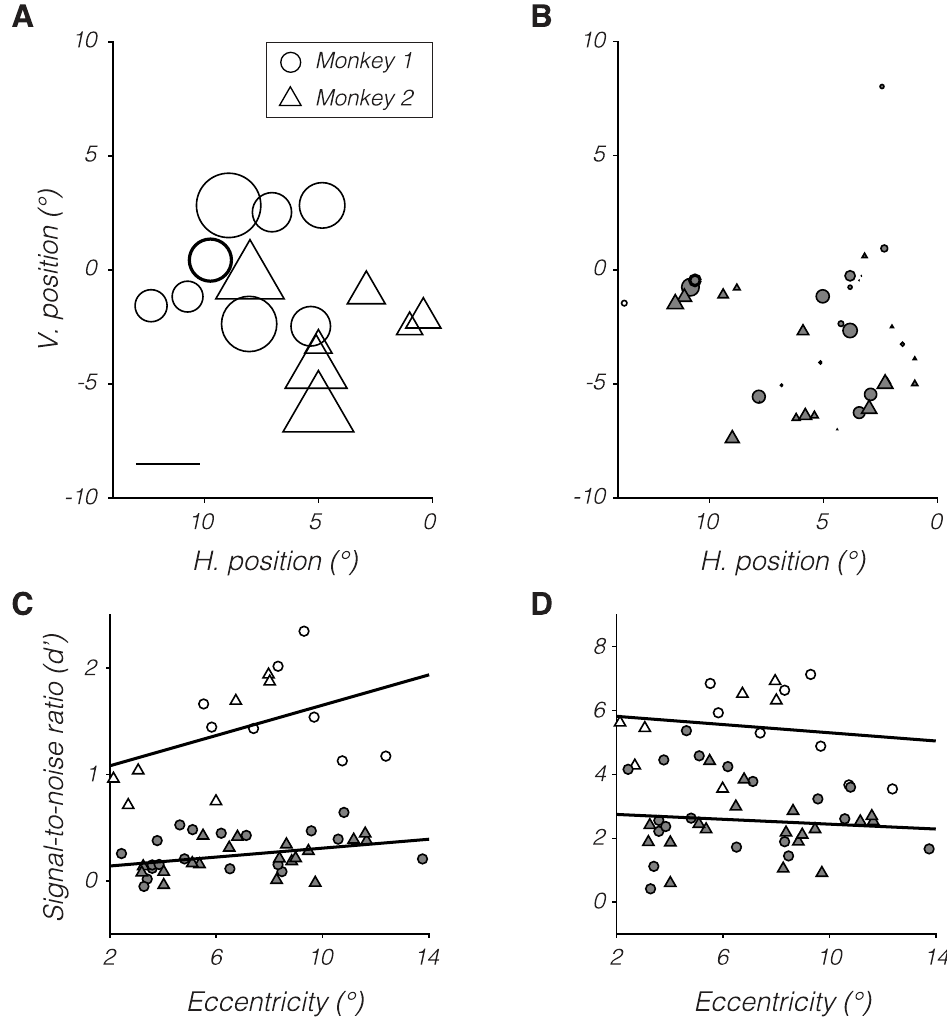
Fig 3. Dependence of d 0 on RF location for monkey 1 (circles) and monkey 2 (triangles). (A and B) Symbol position represents RF location in visual space, and symbol size represents d 0 for magnocellular (A) and parvocellular neurons (B). Scale bar in (A) represents a d 0 of 1 and corresponds to circle diameter and triangle base width in (A) and (B). Example neurons from Fig 2 are highlighted with bold outlines. (C) Data from (A) and (B) replotted as a function of retinal eccentricity. (D) Data from (C) multiplied by population scale factors. Open and filled symbols in (C) and (D) represent data from magnocellular and parvocellular neurons, respectively. Symbol size in (C) and (D) is not meaningful. Data are available at https://github.com/horwitzlab/LGN-temporal-contrast-sensitivity/blob/master/ DataByFigure.xlsx. H., horizontal; RF, receptive field; V. vertical.